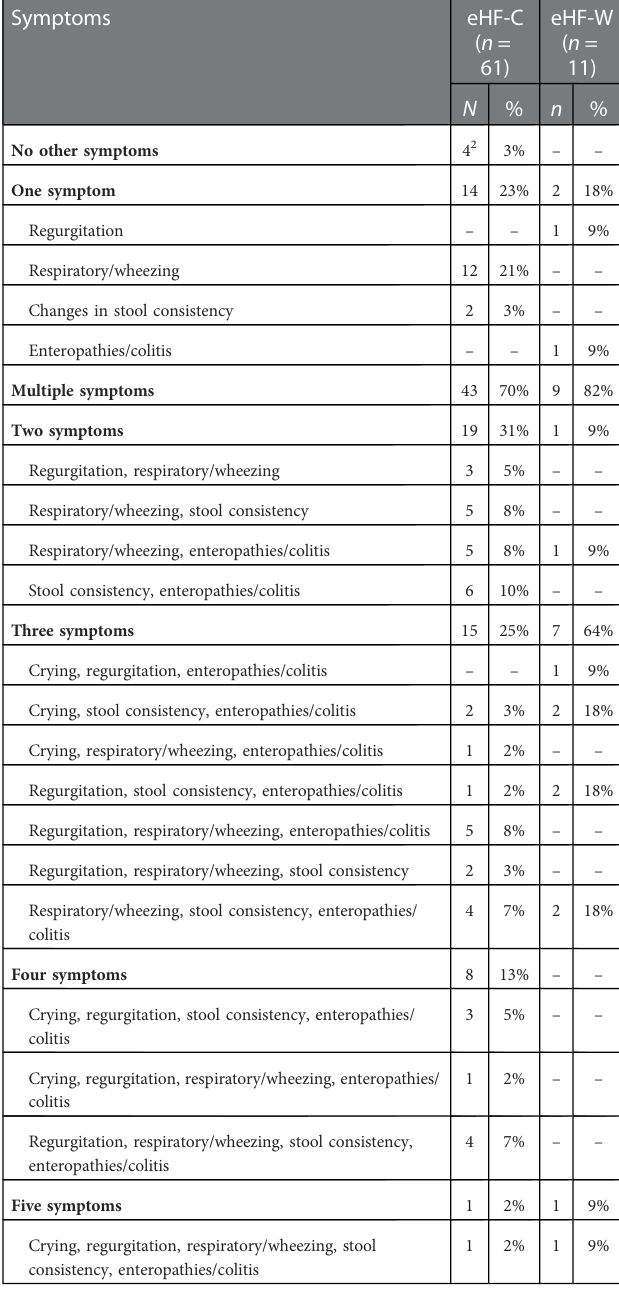
TABLE 6 Prevalence of other symptoms 1 in both groups, presented as number of subjects (counts) and